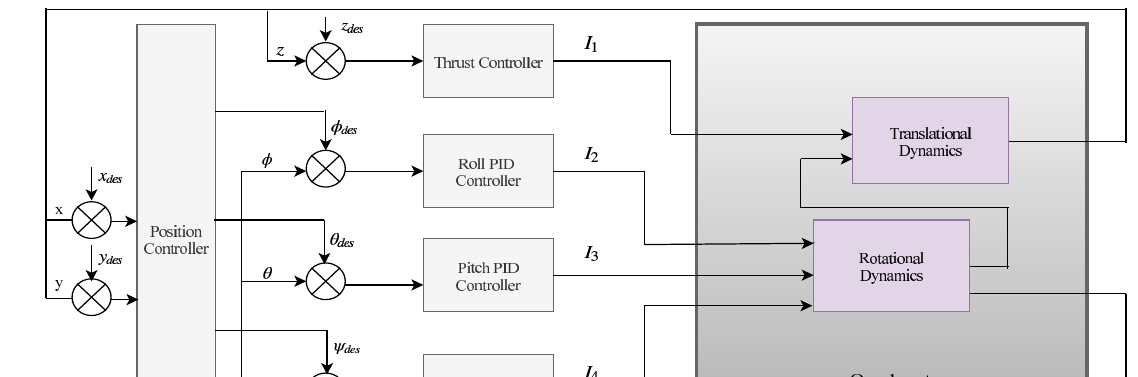
Figure 2. Block diagram of a quadcopter